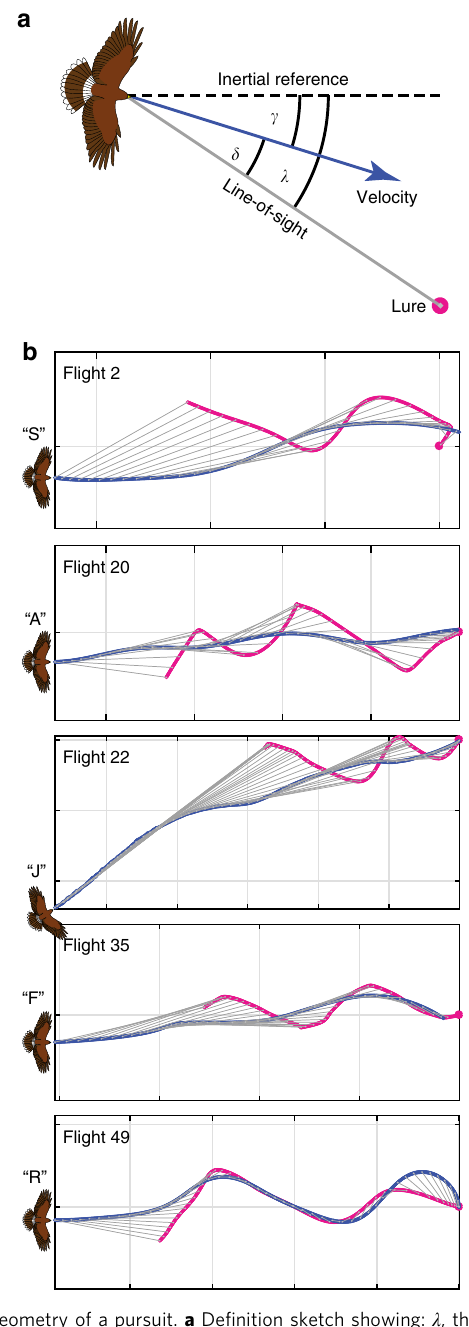
Fig. 2 Geometry of a pursuit. a De fi nition sketch showing: λ , the line-of- sight angle measured between the line-of-sight (grey line) from hawk to target, and some arbitrary inertial reference direction (dashed line); γ , the track angle measured between the hawk ’ s velocity vector (blue arrow) and the inertial reference direction (dashed line); δ , the deviation angle measured between the line-of-sight from hawk to target (grey line), and the hawk ’ s velocity vector (blue arrow). b 2D trajectory plots showing how the instantaneous line-of-sight (grey line) between the hawk (blue) and lure (magenta) varies through a fl ight for one randomly selected fl ight per bird. Note that although the line-of-sight is sometimes aligned with the direction of fl ight (as is expected under the geometry of pure pursuit), the direction of the line-of-sight itself is rarely held constant (as would have been expected under the geometry of parallel navigation).